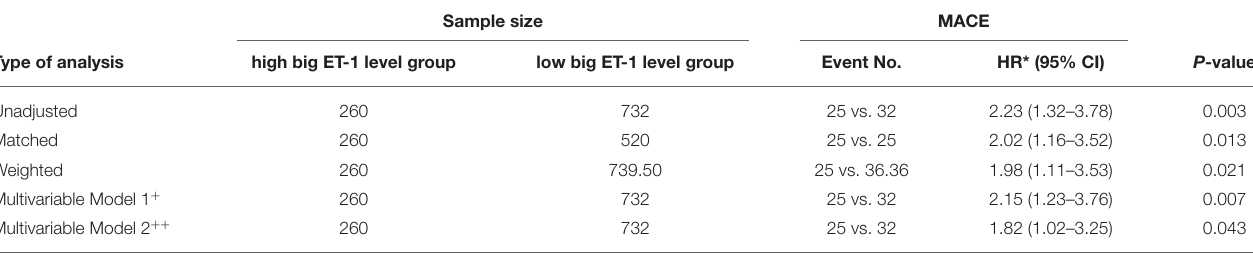
TABLE 3 | Summary of primary end-point events and hazard ratio of the high big-ET-1 level group.